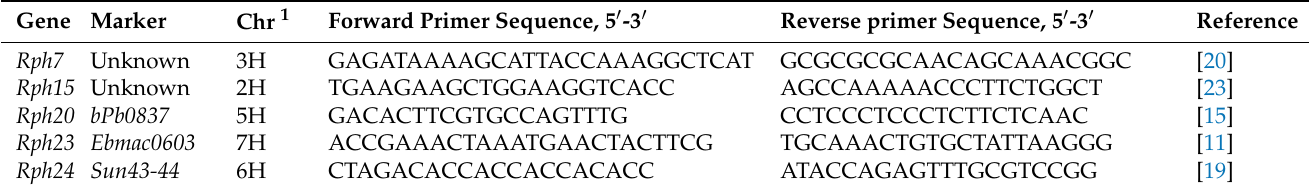
Table 4. Details of markers and sequences of the Rph7 , Rph15 , Rph20 , Rph23 and Rph24 primers used in this